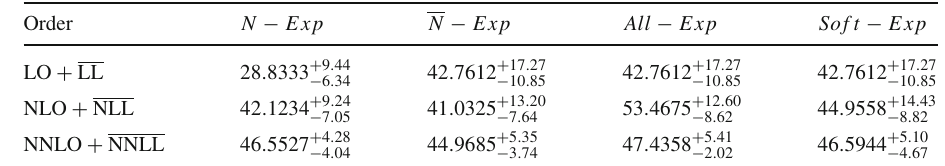
Table 15 A comparison of SV + NSV resummed